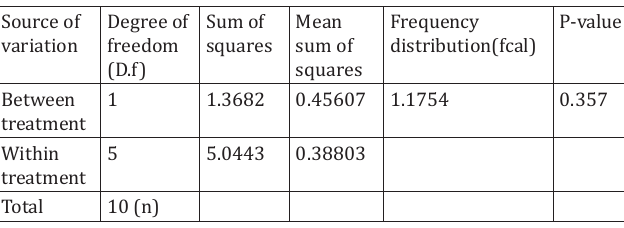
Comparison of testes weight differences of the animals during the experimental period of 21 days.